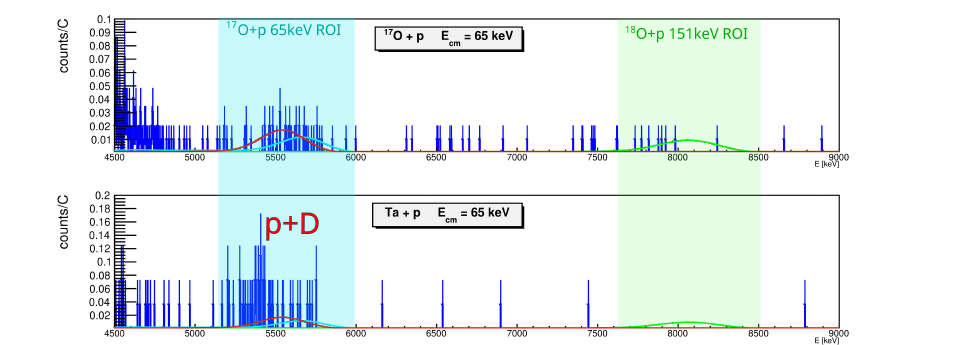
Figure 3. Spectra acquired shooting a E lab = 80keV proton beam on 18 O (top), 17 O (top) targets and naked Ta backings (bottom). The p + d peak in the bottom spectra indicates a contamination in the Ta backings estimated at 3 p.p.m. level. The coloured peaks are shown to guide the eye.